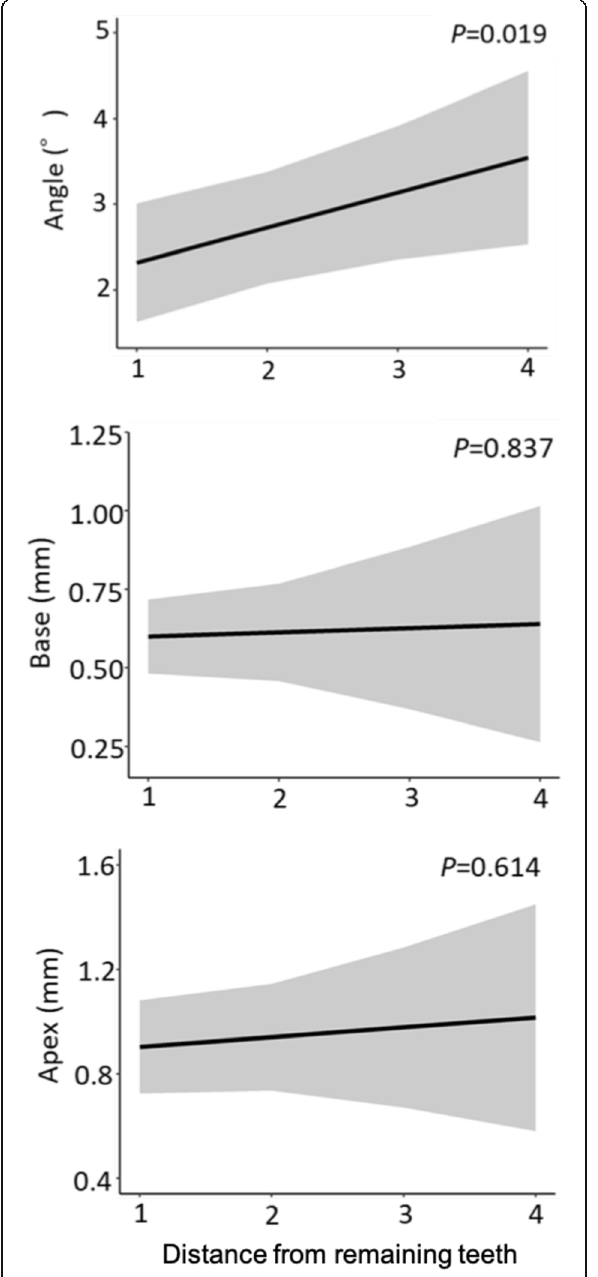
Fig. 8 The errors caused by differences in distance from remaining teeth to the placement position. The shaded area shows 95% confidence intervals